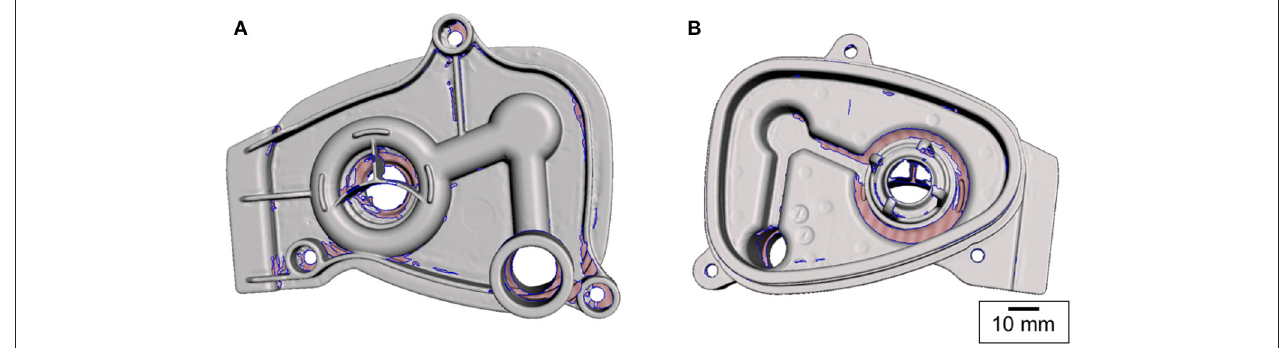
FIGURE 2 | Surface mesh obtained by 3D scanning. The pink-shaded areas (bounded by the blue contours) represent the missing information. The scanner was unable to collect this information due to shadowing [ (A) top and (B) bottom